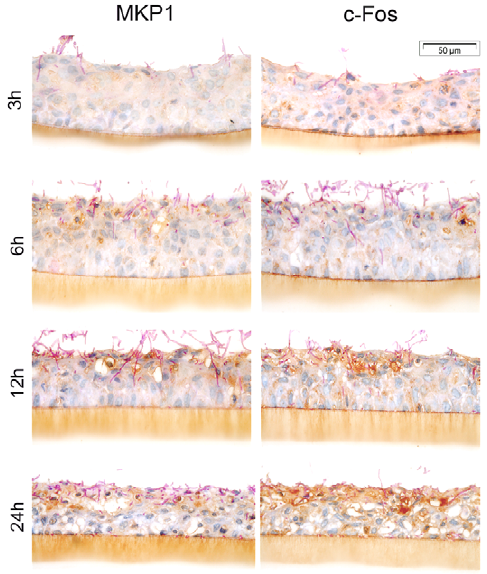
Figure 6. Expression of MKP1 and c-Fos in vaginal RHE. Increase in MKP1 and c-Fos expression in vaginal epithelium is associated with C. albicans SC5314 hypha formation, with minimal activation at the surface by 3 h and gradually increased activation co-localising in the epithelial layers where hyphae penetrate and invade at 6, 12 and 24 h (dark brown staining). Resting levels of MKP1 and c-Fos expression can be seen in areas without C. albicans at each time point (sectional